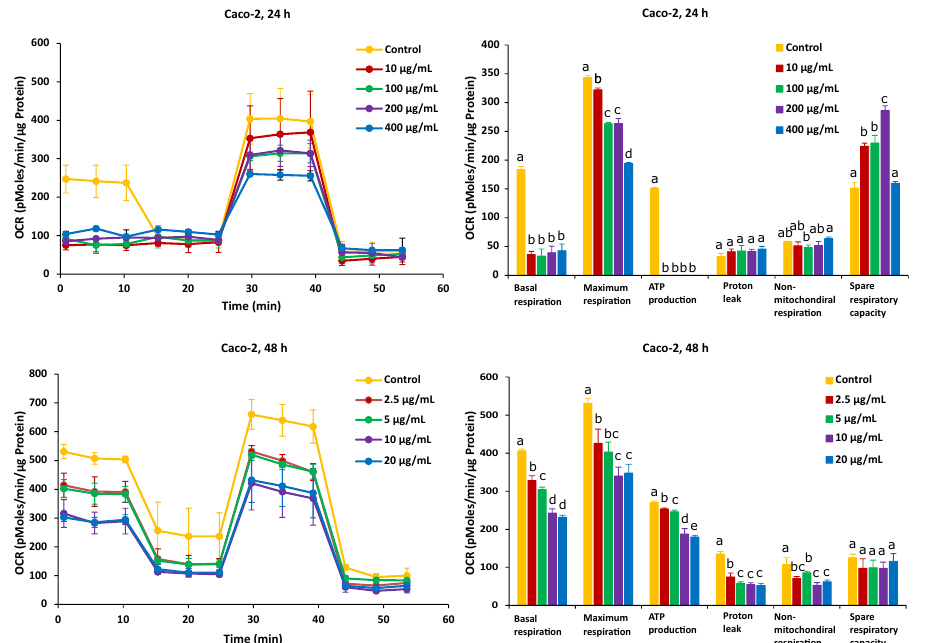
Figure 3. Effect of FB1 on oxygen consumption rate (OCR) ( left ) and different mitochondrial parameters ( right ) in Caco-2 cells after 24 h and 48 h of exposure. Data (at least four technical replicates) are expressed as mean ± standard deviation. Mean values with different letters (a–e) within each mitochondrial parameter indicate significant differences ( p < 0.05) among different FB1 treatments according to one way ANOVA test followed by Tukey HSD multiple-comparison test as a post hoc analysis.